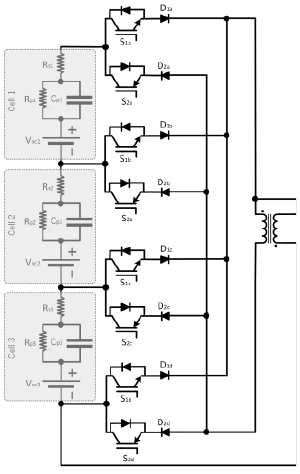
Figure 17. Flyback converter.